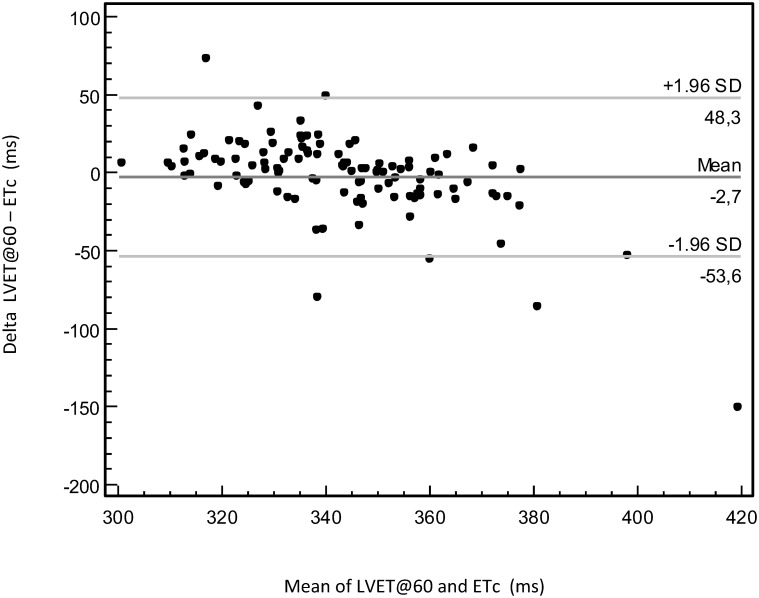
Agreement between ETc and LVET@60.Bland-Altman plot of left ventricular ejection time adjusted to a heart rate of 60 bpm (LVET@60) by tonometry and left ventricular ejection time compensated (ETc) by photoplethysmography, depicting the relationship of difference of measurements (Delta LVET@60 –ETc) and mean value of measurements.